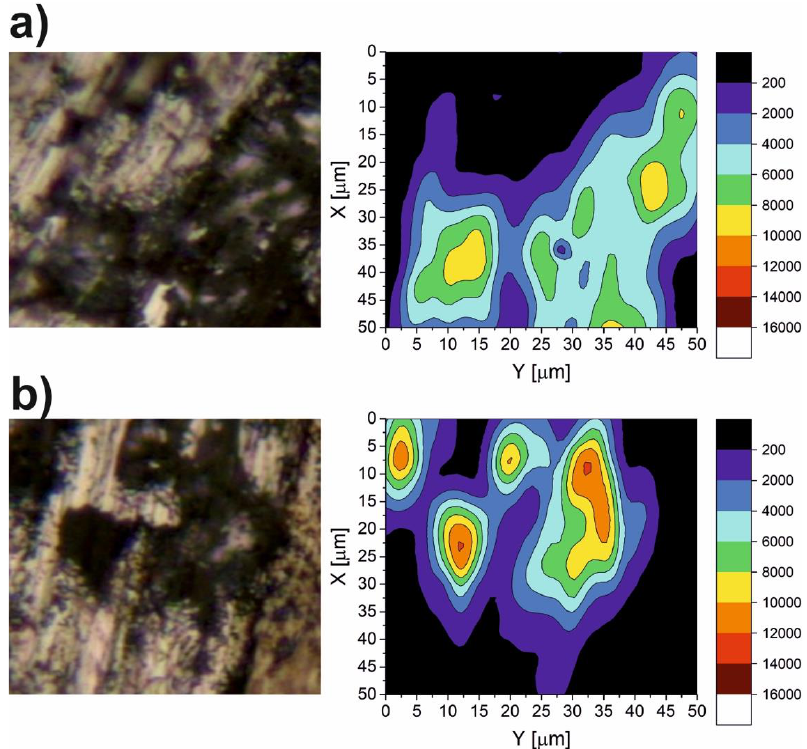
Figure 12. The Raman maps of Ni-10% CaF 2 ( a ) and Ni-20% CaF 2 ( b ) self-lubricating composites after wear test at 200 °C.